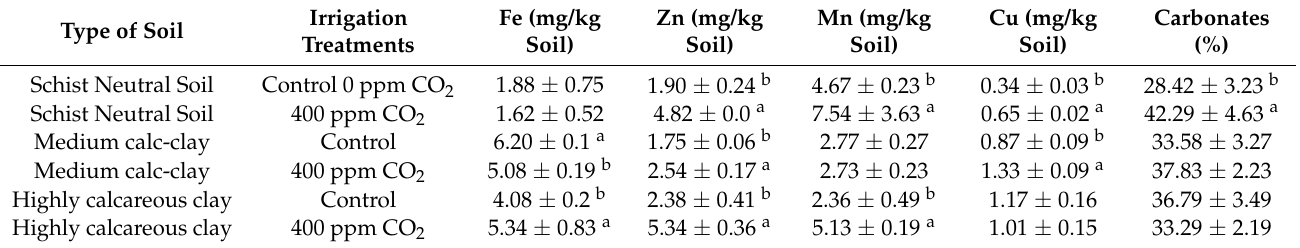
Table 4. Mineral composition of the soil in pots with plants with three substrates. Type of soil: schist neutral soil, medium calcareous clay soil (medium calc-clay), and highly calcareous clay soil. Treatment: treated with non-acidified water (Control pH 7.5) and water carbonated with 400 ppm CO 2 . The results correspond to the third-year experiment on post-harvest samples (after 6 months of carbonated irrigation). a,b : different letters denote a statistically significant difference ( p < 0.05) between treatment for the same type of soil. The results show the mean value and standard deviation.